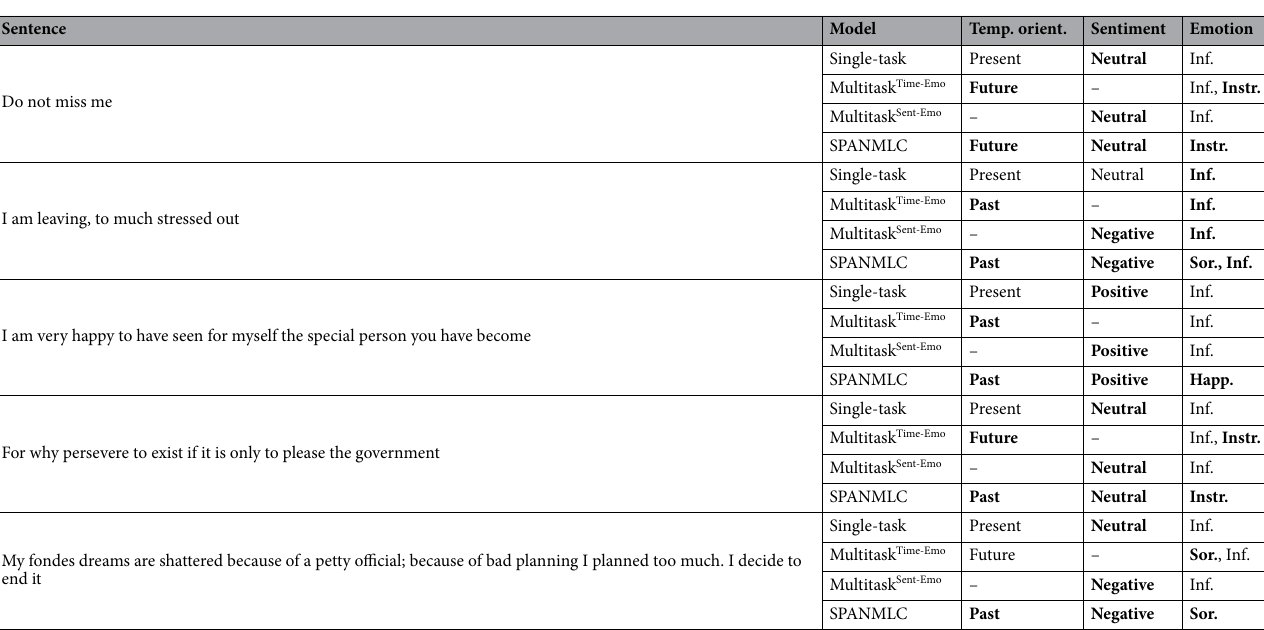
Table 6. Comparison among the performances of the single-task systems, dual multitask systems and the proposed system through qualitative analysis. Texts in bold indicates actual or correct labels. Inf. information, Instr. instructions, Sor. sorrow, Happ. happiness.